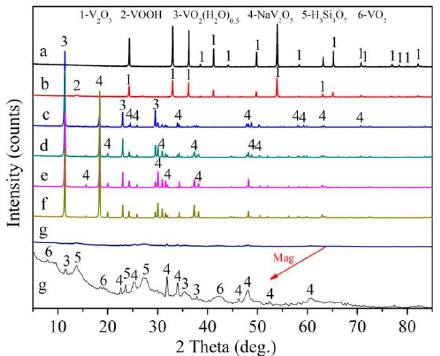
Figure 11. XRD patterns of the precipitates obtained at different silicon concentrations of ( a ) 0.1 g/L; ( b ) 0.2 g/L; ( c ) 0.31 g/L; ( d ) 0.39 g/L; ( e ) 0.52 g/L; ( f ) 1.01 g/L, and ( g ) 3 g/L in the feed solutions.